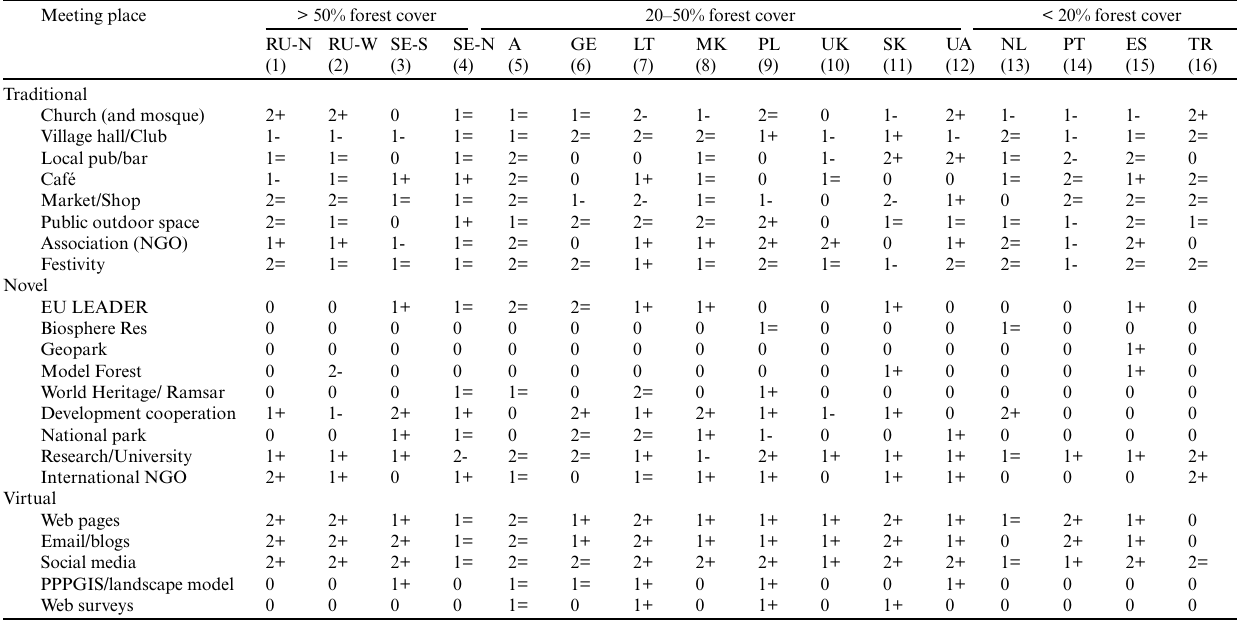
Table 2 . Expert assessment of viability/activity of meeting places in hotspot areas belonging to one of three groups of fora (traditional, novel, and virtual). Occurrence today is marked as active (2), present (1), or (near) absent (0), and the trend from past (before 1980s † ) to present is marked as increasing (+), stable (=), or negative (-). See Table 1 and Figures 2, 3, 4 for details about the case study regions and hotspots. The Likert ranks are shown in Figure 6. PPGIS = Public Participation Geographic Information Systems. †